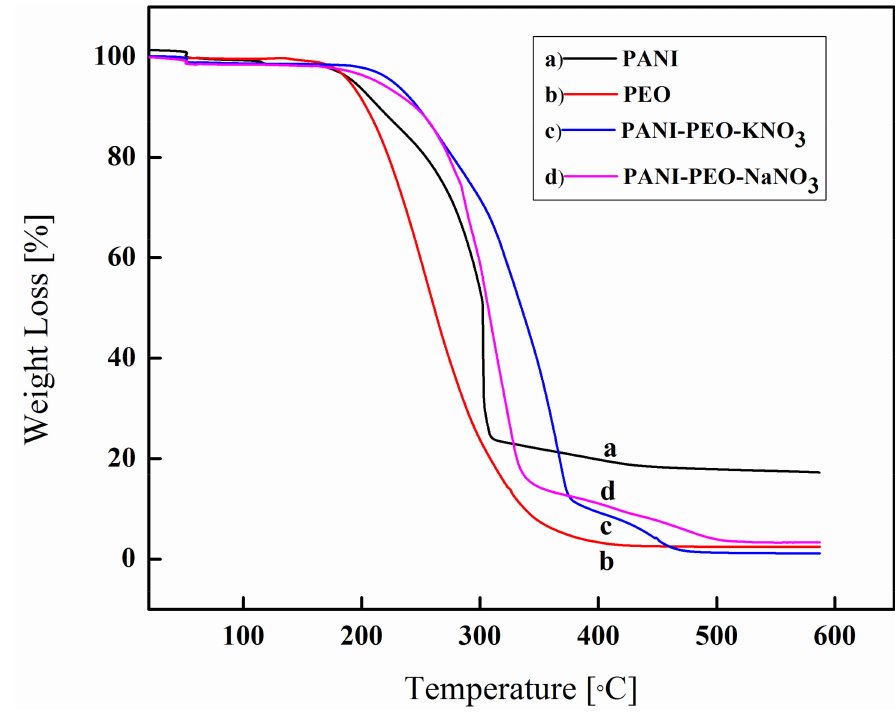
Figure 2. Curves for ( a ) PANI ( b ) PEO ( c ) PANI–PEO–KNO 3 ( d ) PANI–PEO–NaNO 3 .